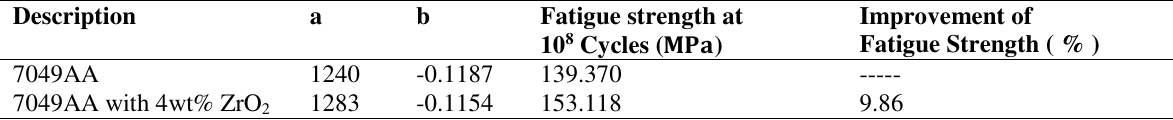
Fatigue Parameters and Fatigue Strength of AA 7049 with and without 4wt% ZrO 2 .